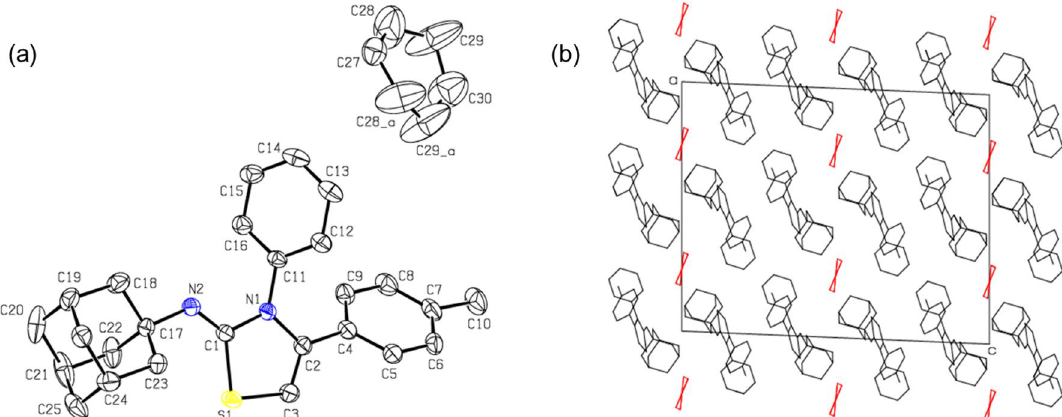
Figure 4. ( a ) ORTEP plot of compound 5d and a cyclohexane solvent in the crystalline lattice (symmetry element ( a ) − x + 1/2, y, − z). The displacement ellipsoid is drawn at the 50% probability level along atom- labelling scheme and ( b ) columnar packing mode of compound 5d along the crystallographic ac plane. The lattice cyclohexane solvent is shown in red. All H atoms have been omitted for the sake of clarity.